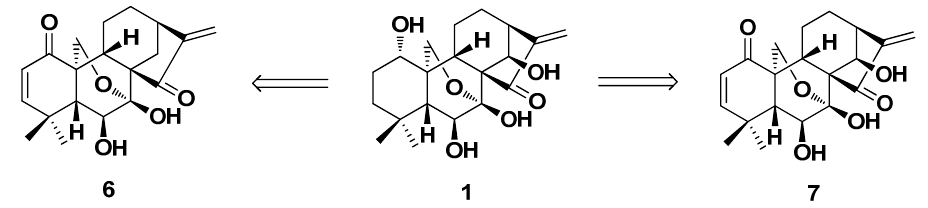
Figure 4. Synthesis of eriocalyxin B ( 6 ) and 14-hydroxyeriocalyxin B ( 7 ) from oridonin.